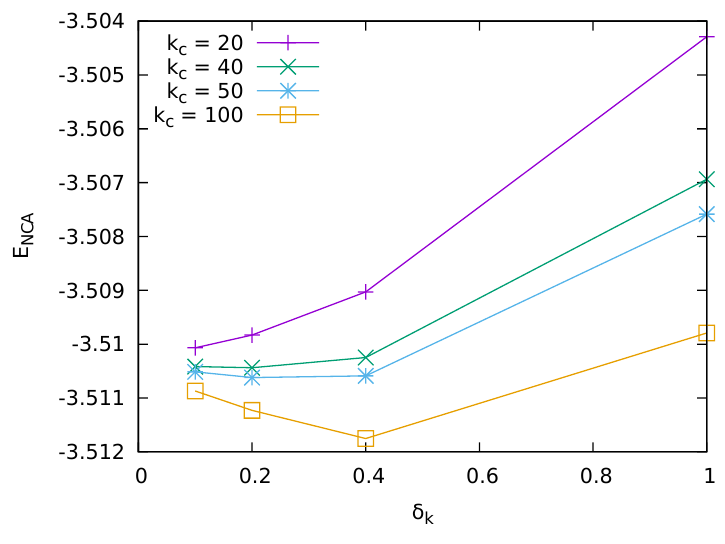
Figure 22: Dependence of the polaron energy in the NCA approximation on the momentum cutoff k and the number of momenta N chosen uniformly with spacing δ c k = 20.48 with 512 time points chosen on a logarithmic grid, parameters are µ = − 4, τ max and 2 16 Matsubara frequencies. The energy was determined from linear regression of the exponential tail of the Green function between τ = 5 and τ =